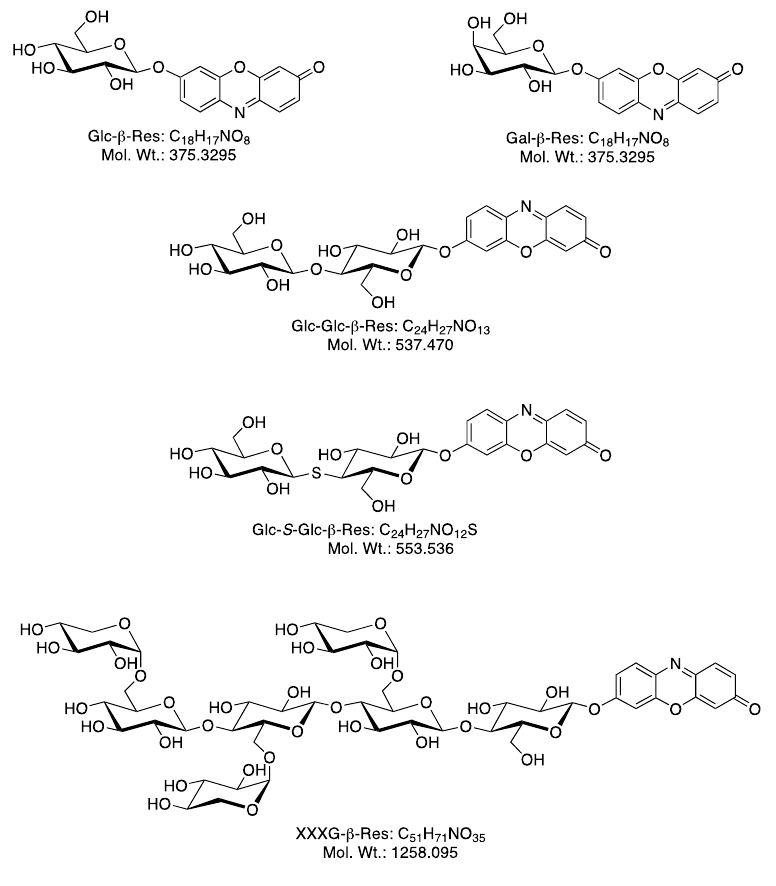
Figure 1. Structures of the fluorogenic substrates used in this study (Glc - β-Res;